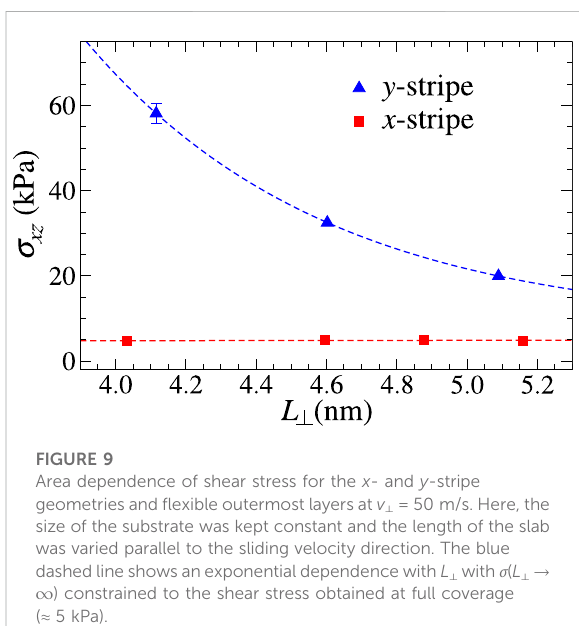
FIGURE 9 Area dependence of shear stress for the x - and y -stripe geometries and fl exible outermost layers at v ⊥ = 50 m/s. Here, the size of the substrate was kept constant and the length of the slab was varied parallel to the sliding velocity direction. The blue dashed lineshows an exponential dependence with L ⊥ with σ ( L ⊥ → ∞ ) constrained to the shear stress obtained at full coverage ( ≈ 5